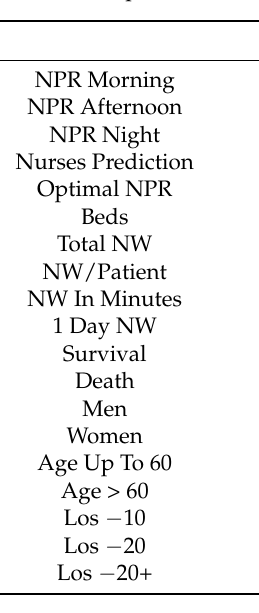
Table 5. Descriptive results of NW and daily ICU data.